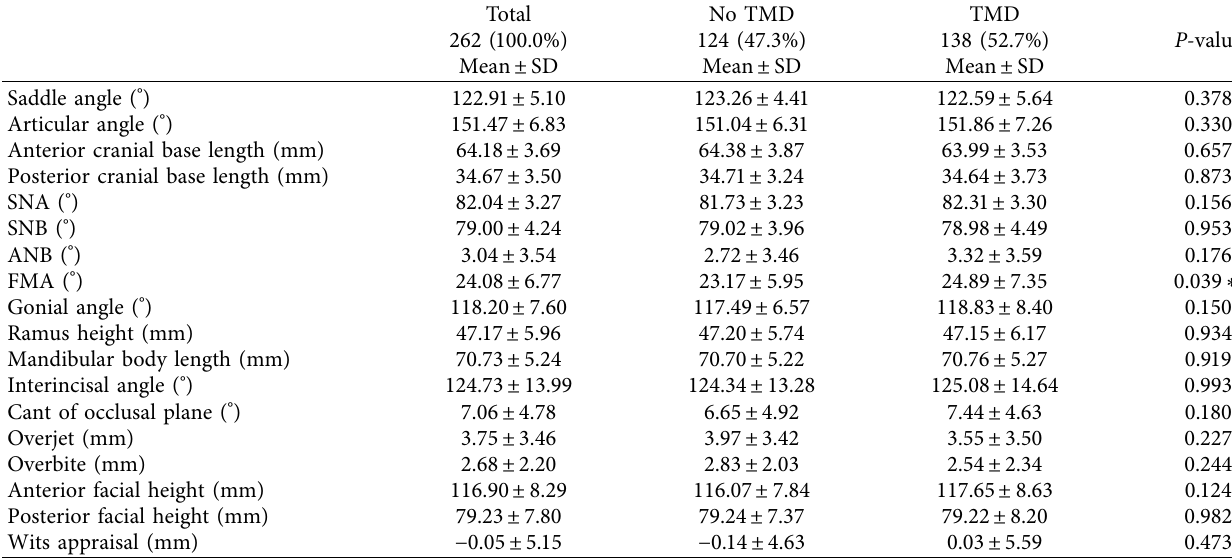
Figure 2: Results of the Fonseca anamnestic index (FAI) scale survey. Left panel, all included patients; center panel, patients with no TMDs; and right panel, patients with TMDs. Each bar shows the answer distribution of an item on the FAI survey. The percentage in each row represents the proportion of patients with a score of 5 or 10, indicating the prevalence rate of the TMD-related symptom or risk factor reflected by every question. TMJ: temporomandibular joint, TMD: temporomandibular disorder. Table 2: Comparison of craniofacial morphological parameters between patients with and without